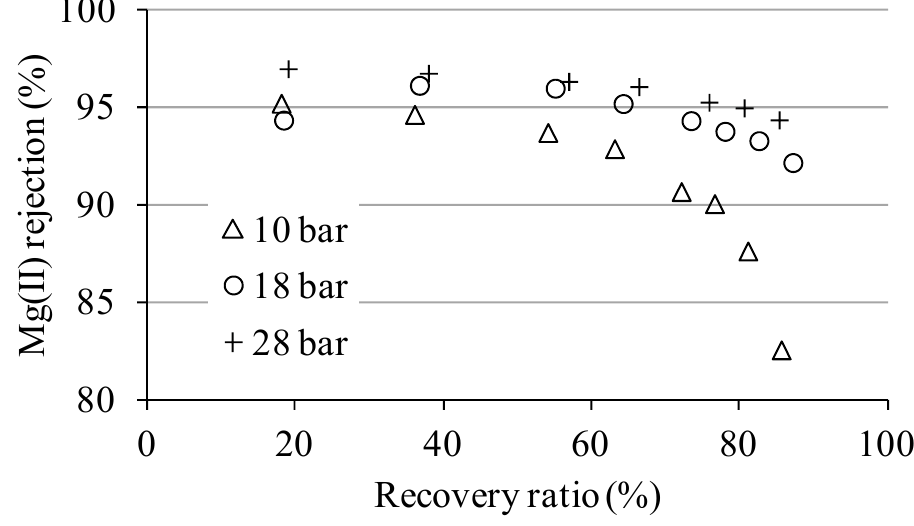
Figure 2. Mg(II) rejection values at 10, 18 and 28 bar ( ∆ , ○ and +, respectively) as a function of the recovery